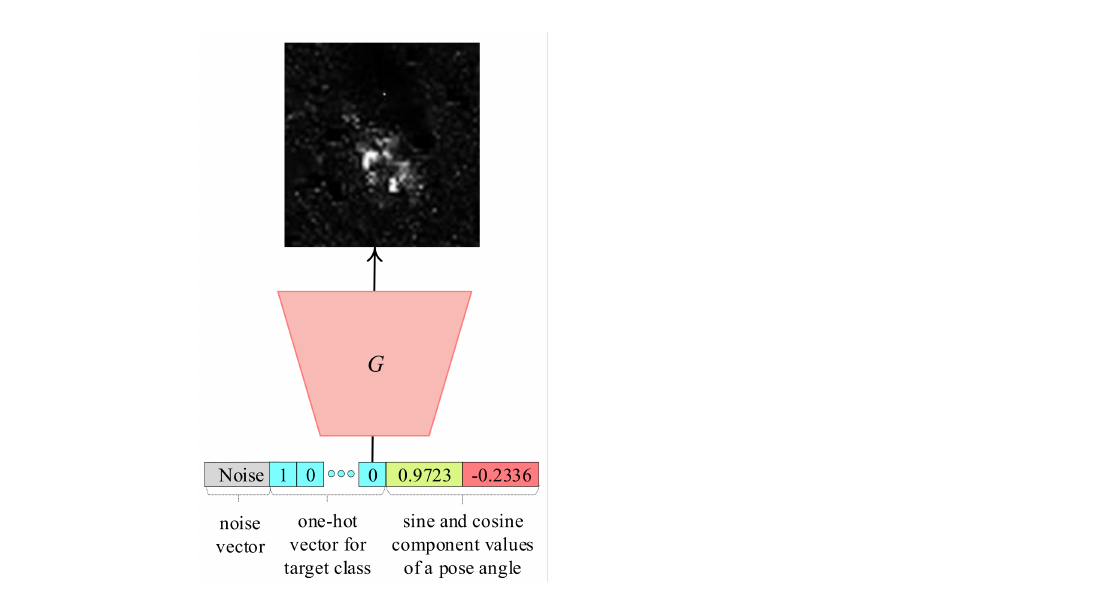
Figure 4. An example of how to generate the intended class of the SAR image with the desired pose angle by PeaceGAN: the “BMP2”-class SAR image (first class) with pose angle 346.49 ◦ of D 17